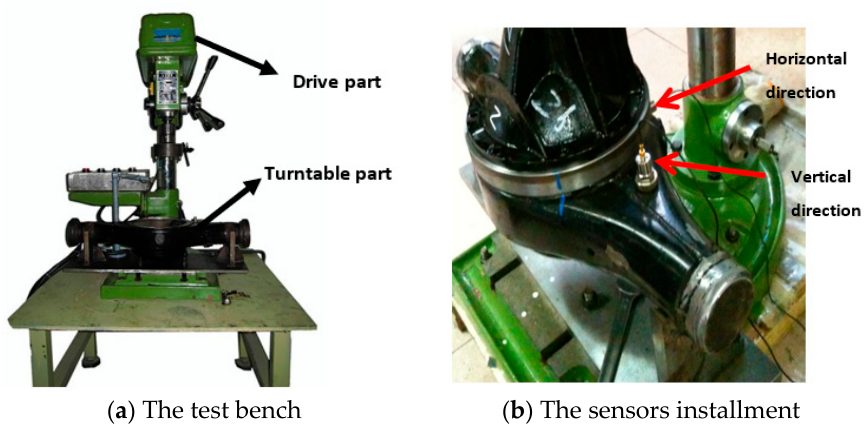
Figure 5. The test bench.